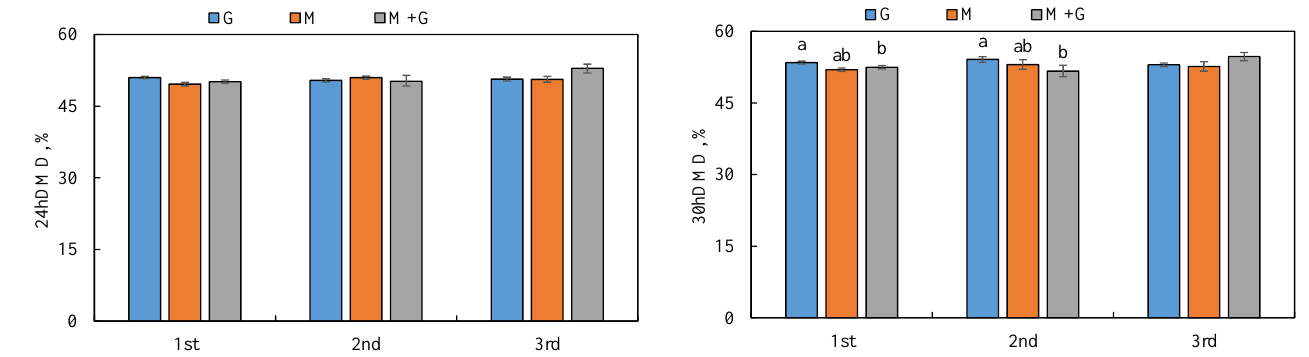
Figure 3. Showing 24 h and 30 h in vitro digestibility of three cultivated grasslands. Lowercase letters indicate the differences among different pastures in the same month. Table 1. Prediction of forage digestibility using forage nutrient